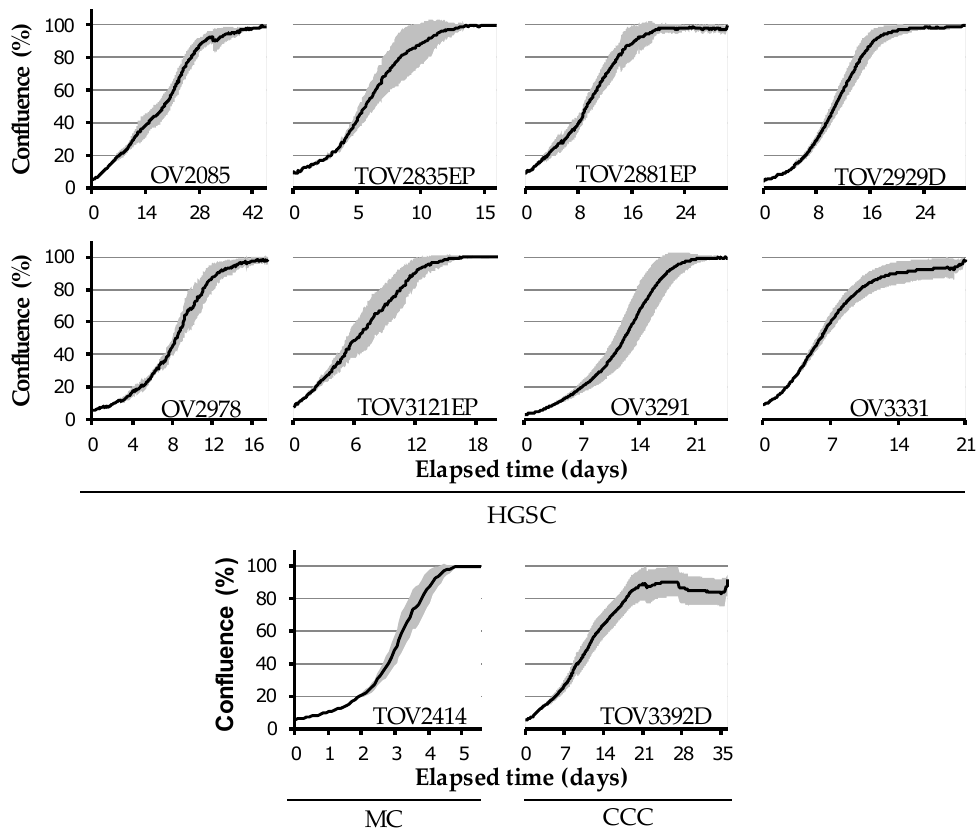
Figure 5. Confluence-based proliferation curves by live cell imaging. Cell proliferation of each cell line was determined by measuring confluence every 2 h. Initial values of confluence were between 5 and 10%, and cells were left to proliferate until confluence reached approximately 100%. Grey zones represent SEM ( n = 3).